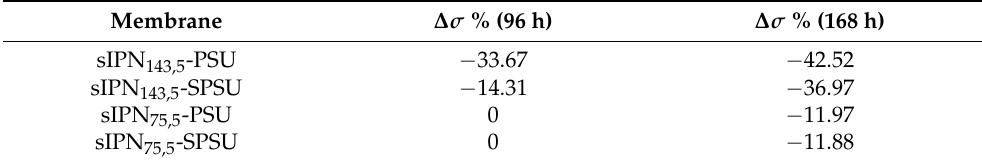
Table 3. Ionic conductivity variation of the membranes after 96 and 168 h in a 1 M KOH